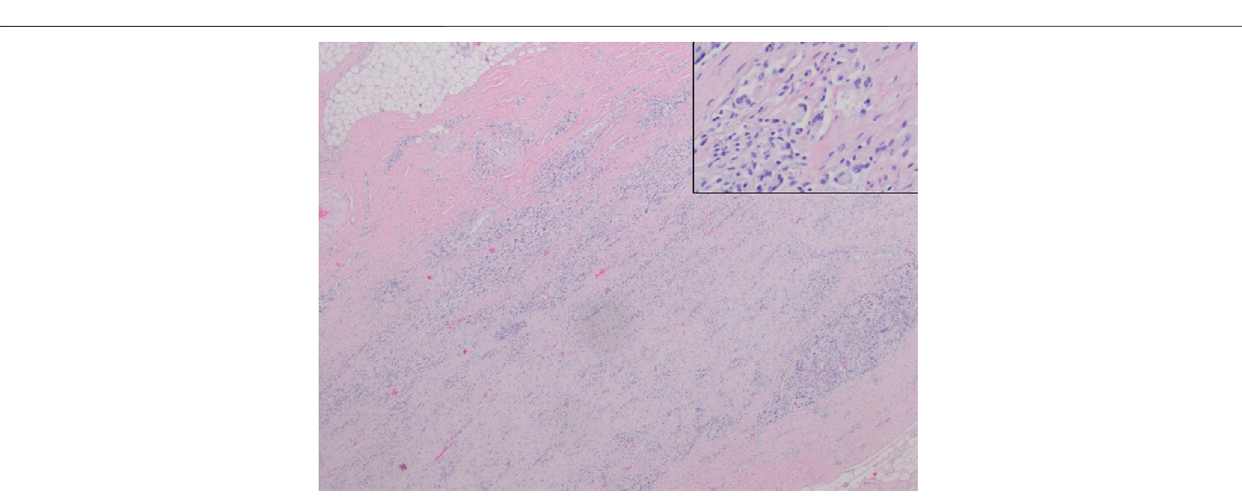
Frontiers in Bioengineering and Biotechnology |